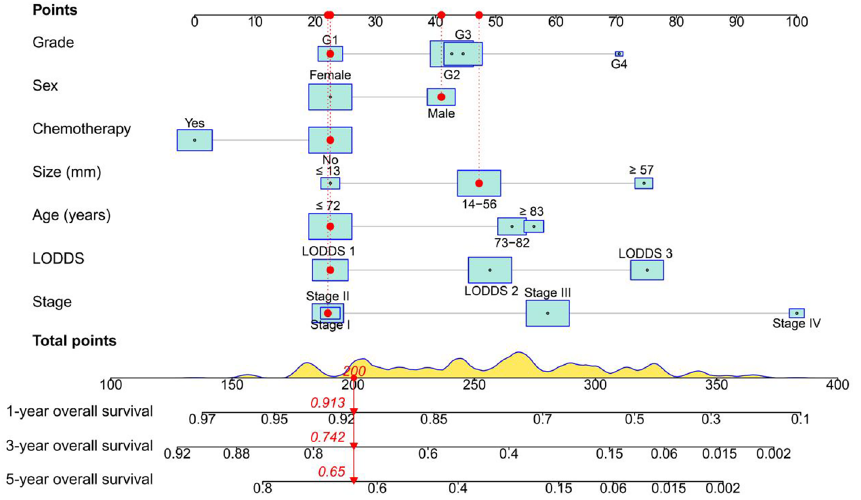
Figure 2. A constructed nomogram for prognostic prediction of a patient with NM-GBA. For category variables, their distributions were reflected by the size of the box (to view boxes of the stage, the smaller one represents stage I and the bigger one represents stage II). The density plot of total points shows the distribution. The patient, a 29-year-old man, had a tumor of 24 mm, G1, stage II, LODDS 1 (−2.479), and did not receive chemotherapy. To use the nomogram, the specific points (black dots) of individual patients were located on each variable axis. Red lines and dots were drawn upward to determine the points received by each variable; the sum (200) of these points was located on the Total Points axis, and a line was drawn downward to the survival axes to determine the probability of 1-year (91.3%), 3-year (74.2%) and 5-year (65.0%) overall survival. NM-GBA non- metastatic gallbladder adenocarcinoma, LODDS log odds of positive lymph